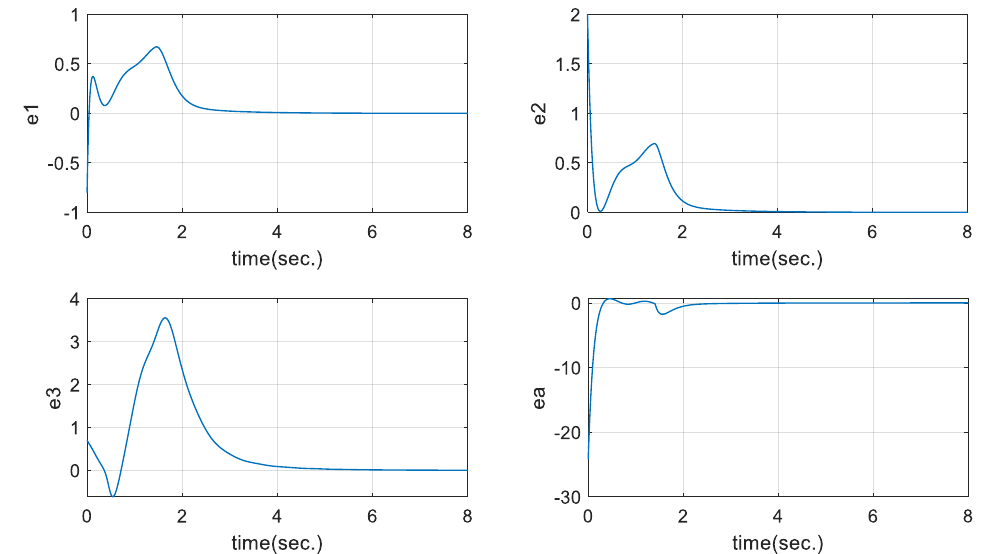
Figure 3. Error state responses.